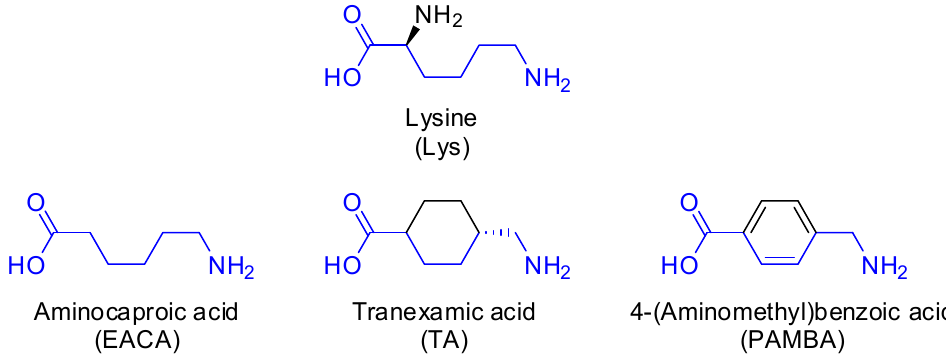
Figure 3. Structure of lysine and its synthetic analogs: aminocaproic acid (EACA), tranexamic acid (TA), and 4-(aminomethyl)benzoic acid (PAMBA).